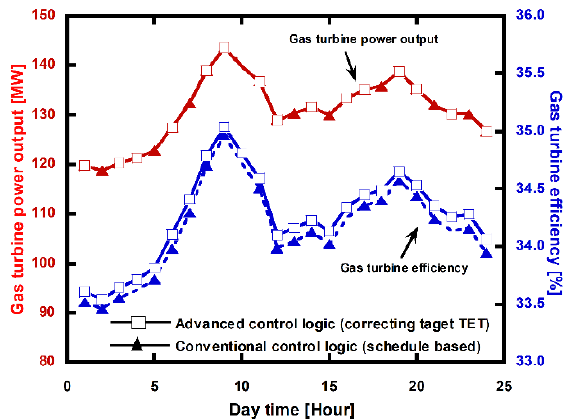
Figure 14. Example of the variations in ambient temperature and electric power demand during a spring day in South Korea.